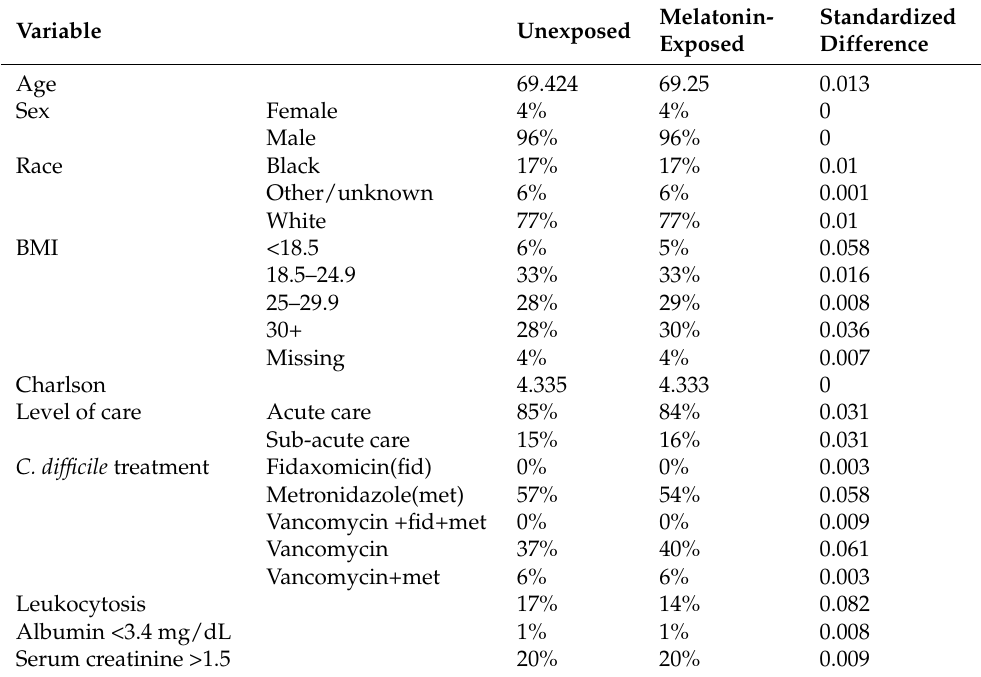
Table 3. Propensity-Score-Weighted Baseline Demographics and Clinical